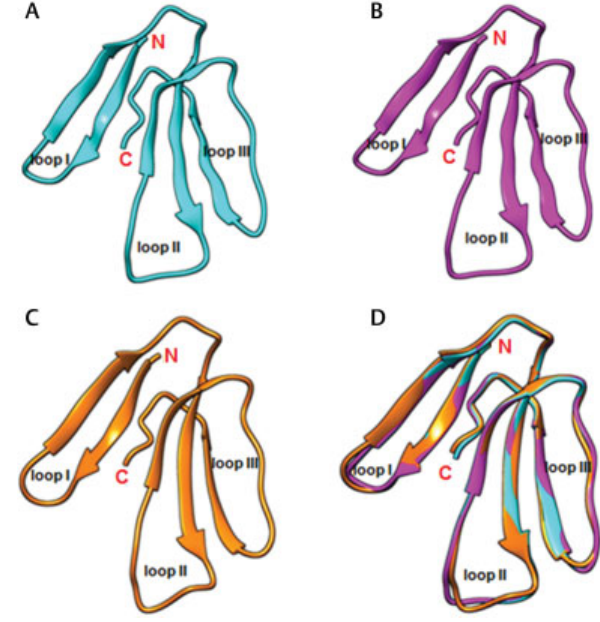
Fig. 3 Three-dimensional structures of toxins. ( A ) Crystal structure of ringhalexin (PDB: 4ZQY). Three-dimensional models of ( B ) najalexin and ( C ) ophiolexin were constructed using ringhalexin structure as the template. ( D ) Superimposed structures of ringhalexin ( cyan ), najalexin ( magenta ), and ophiolexin ( orange ). The loops and N- and C-terminals are labeled. Root mean square deviation (RMSD) between najalexinandringhalexinis0.035 Å, betweennajalexinandophiolexin is 0.771 Å, and between ringhalexin and ophiolexin is 0.769 Å.